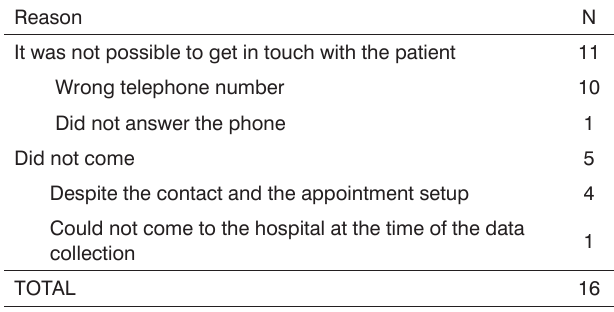
Table 1. Reasons why and number of patients taken off the